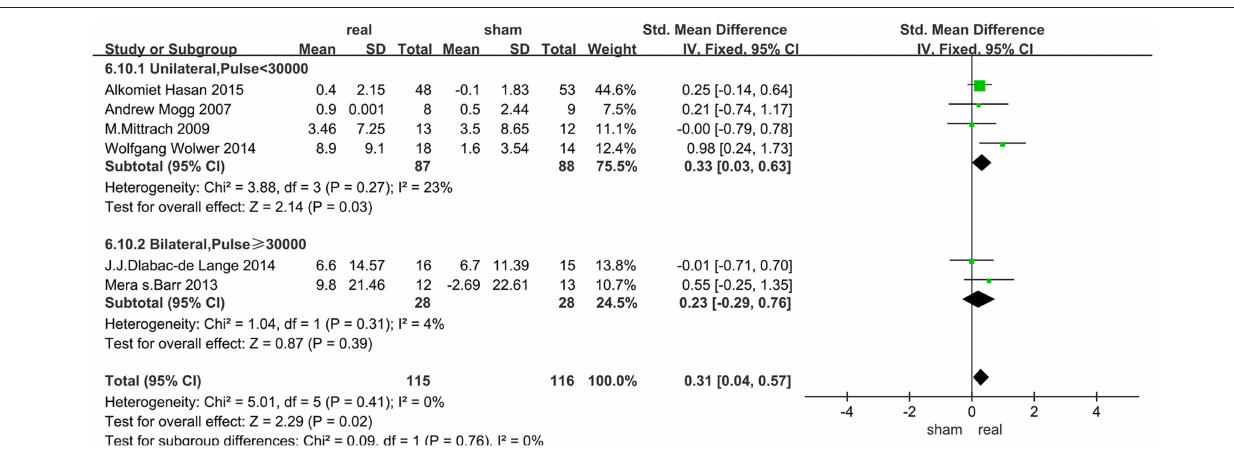
FIGURE 5 | Immediate efficacy of working memory subgroup analysis after rTMS